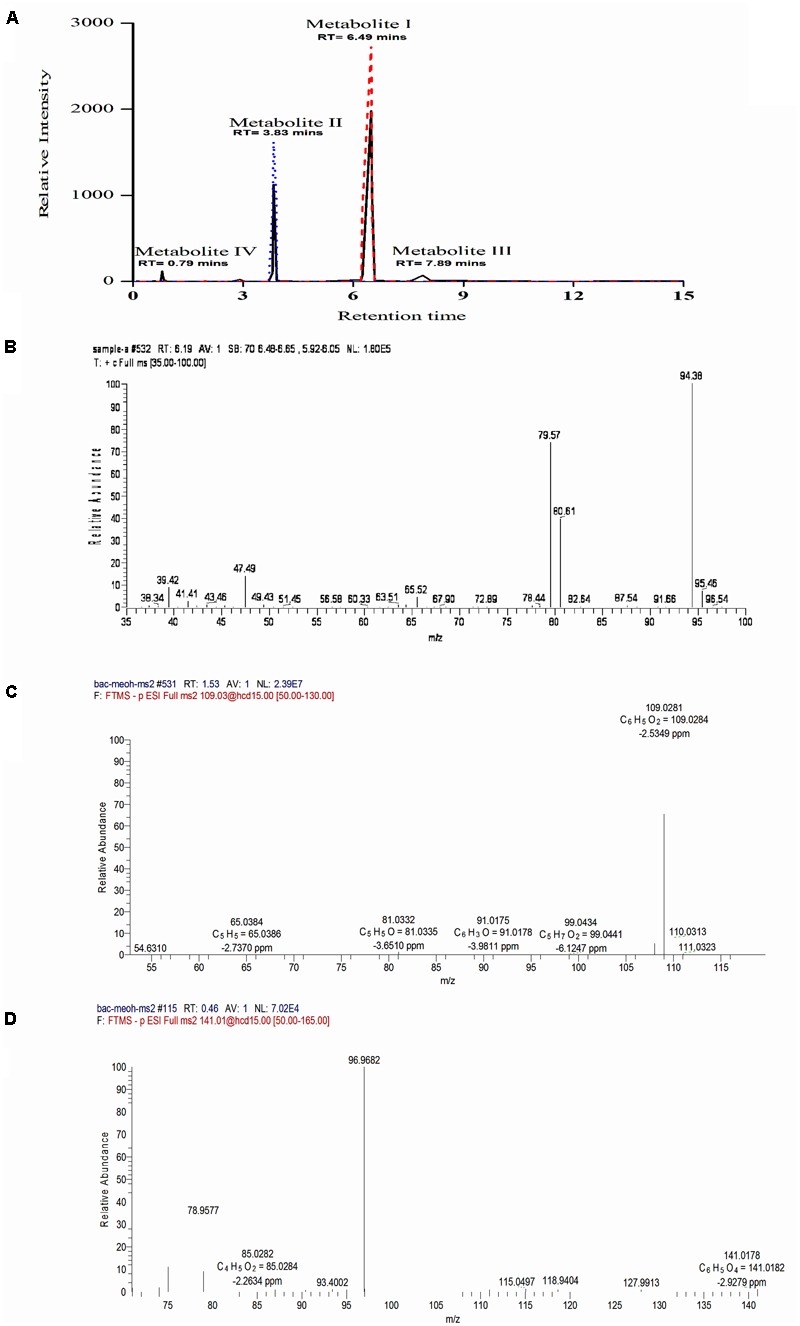
Chromatographic and mass spectrophotometric analysis of the culture supernatant of Y. lipolytica NCIM 3589 after growth on bromobenzene. (A) HPLC profile of the culture broth extracts (—) showing co-elution with the standards, where () indicates the standard phenol and () indicates the standard catechol. Metabolite I and II co-eluted with the standard phenol and catechol respectively. (B) GCMS spectra for Metabolite I. (C) LCMS spectra for Metabolite II. (D) LCMS profile for Metabolite IV.